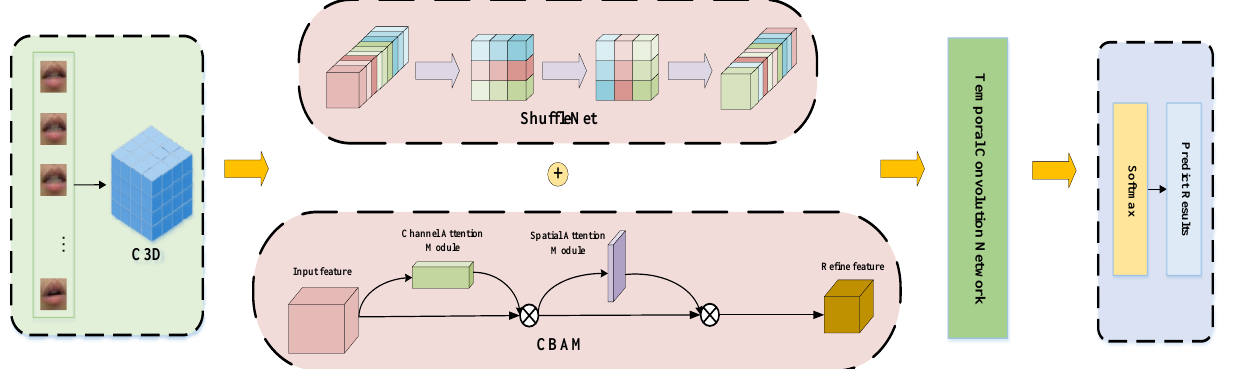
Figure 1. The architecture of the lip-reading model. Given a video sequence, we extract 29 consecutive frames that have a single channel indicating a gray level. The frames firstly go through a 3D convolution with kernel 5 × 7 × 7 called C3D. A ShuffleNet network inserted with the attention module called CBAM is used for spatial downsampling. Finally, the sequence of feature vectors is fed into the Temporal Convolutional for temporal downsampling followed by a SoftMax layer.